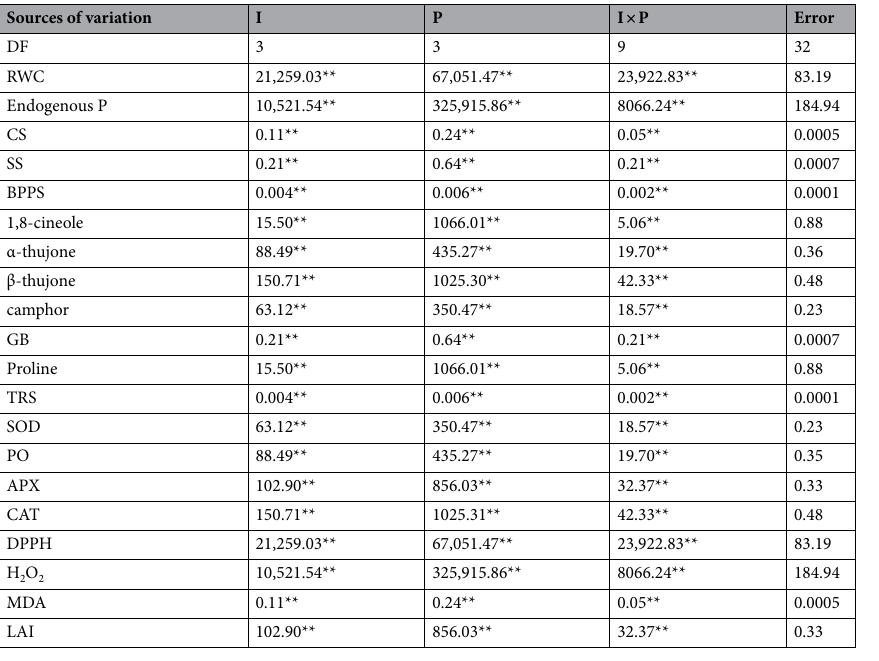
Table 2. Analysis of variance (mean square) of relative water content (RWC), endogenous putrescine, cineole synthase (CS), sabinene synthase (SS), bornyl diphosphate synthase (BPPS), 1,8-cineole, α-thujone, β-thujone, camphor, glycine betaine (GB), proline, total reducing sugars (TRS), superoxide dismutase activity (SOD), peroxidase activity (PO), ascorbate peroxidase activity (APX), catalase activity (CAT), 2,2-diphenyl- 1-picrylhydrazyl (DPPH), Hydrogen peroxide (H 2 O 2 ), lipid peroxidation (MDA) and leaf area index (LAI) of Salvia officinalis influenced by irrigation regimes (I) and putrescine concentrations (P). ns : non-significant. *α ≤ 0.05. **: α ≤